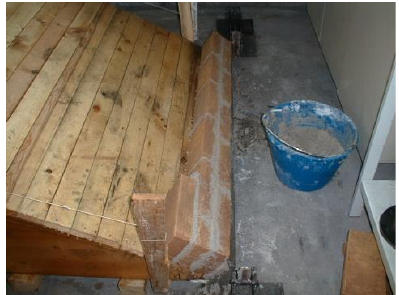
Figure 2. Construction detail for the masonry barrel vaults springing (of BV1-type).